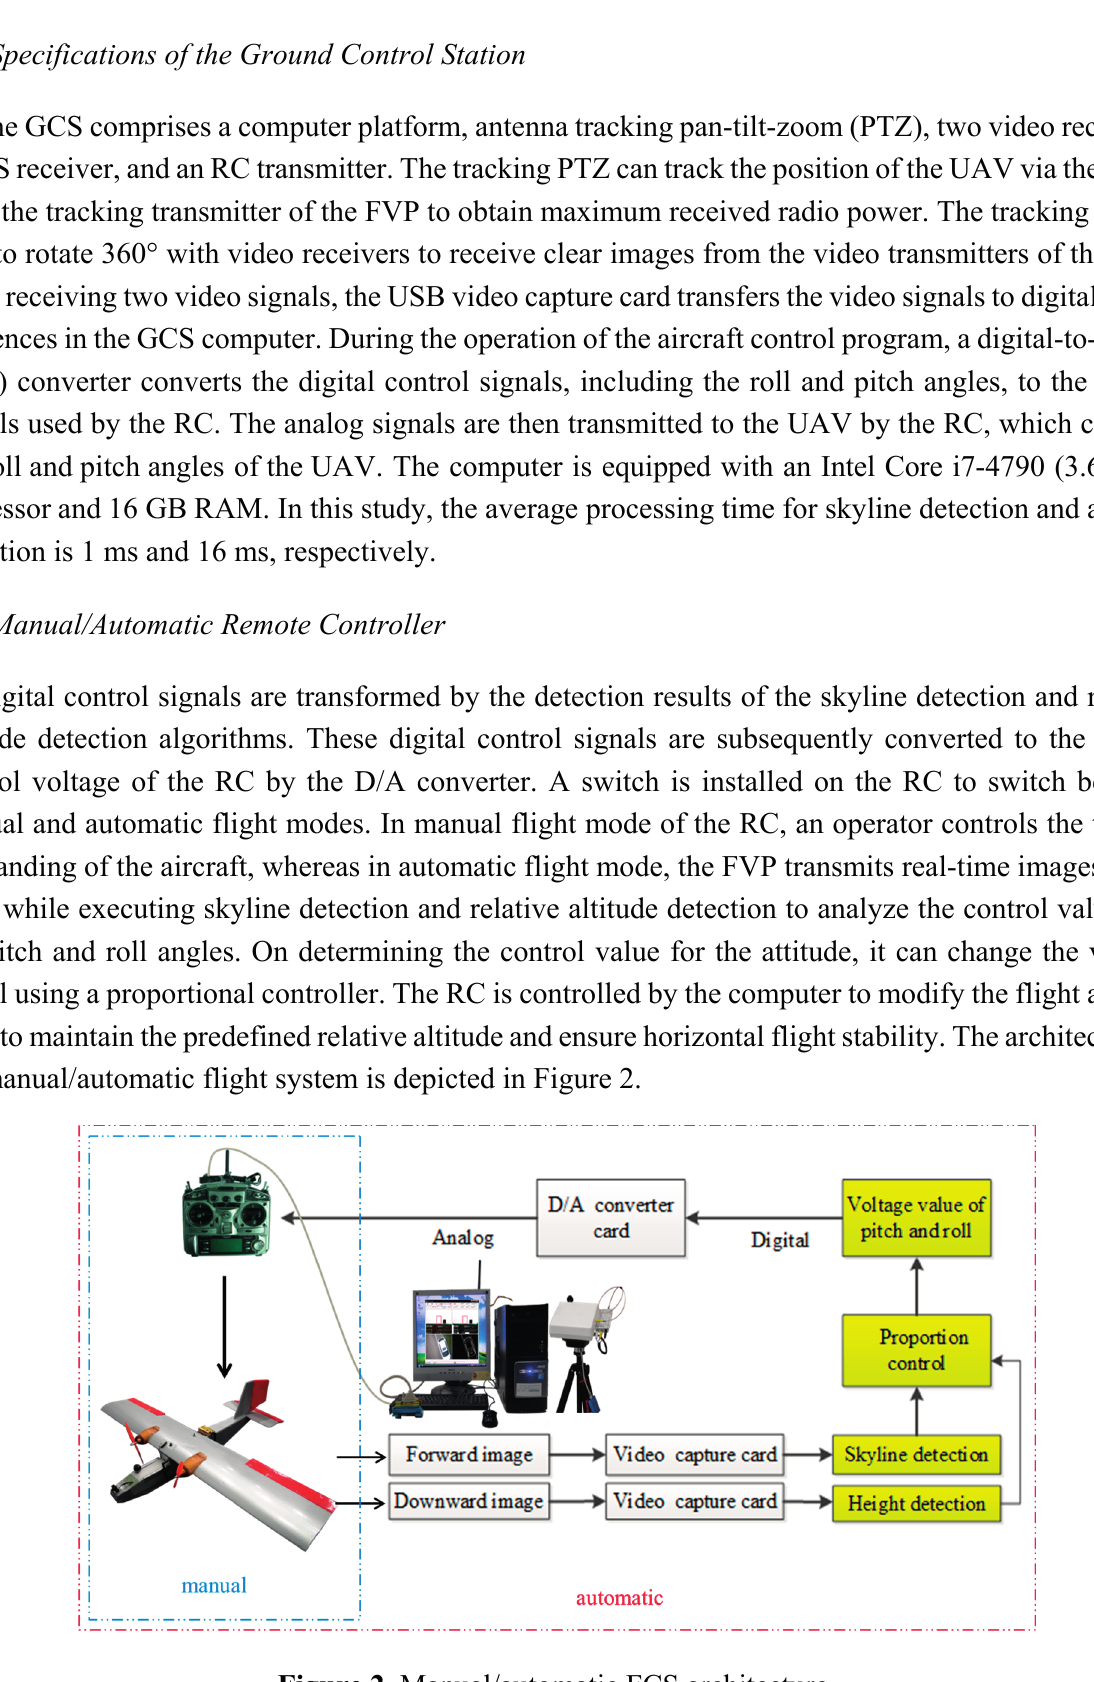
Figure 2. Manual/automatic FCS